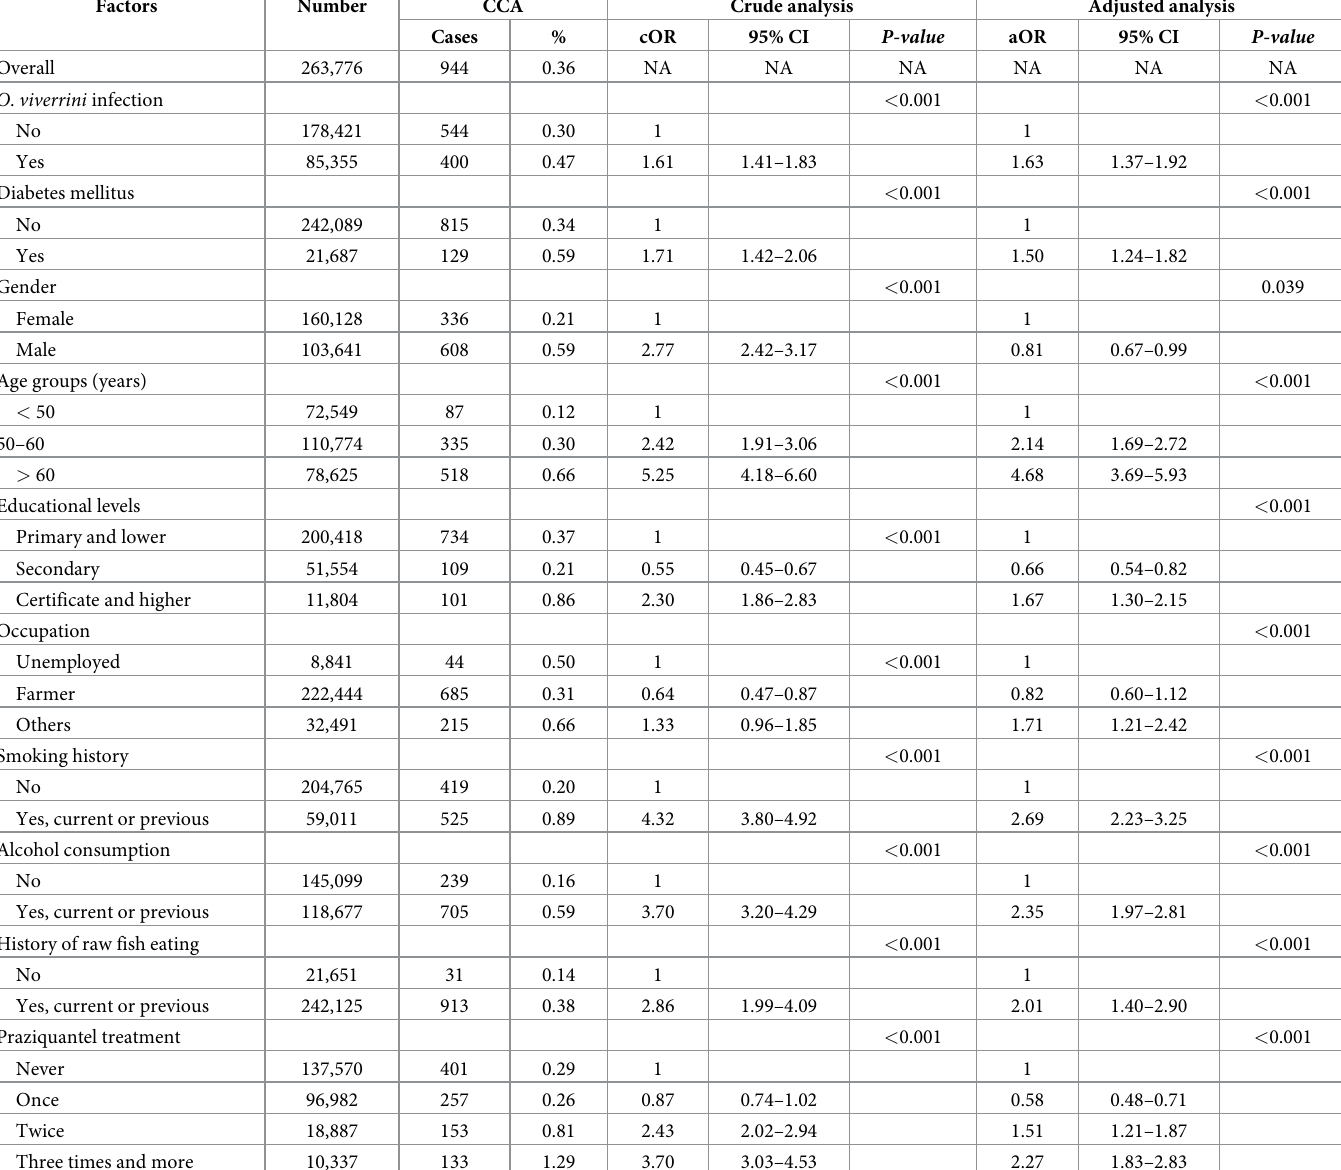
Table 2. Association of O . viverrini infection, diabetes mellitus diagnosis and other factors with cholangiocarcinoma using multilevel mixed-effects logistic regres- sion. The data are presented as number of participants, number and percentage having cholangiocarcinoma, crude odds ratios with their 95% confidence intervals and p- values from likelihood-ratio chi-square tests, and adjusted odds ratios and their 95% confidence intervals and p-values from likelihood-ratio chi-square tests for each